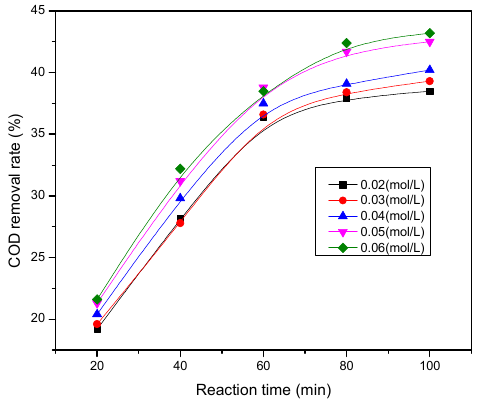
Figure 7. Influence of the concentration of auxiliary electrolyte on the COD removal rate.